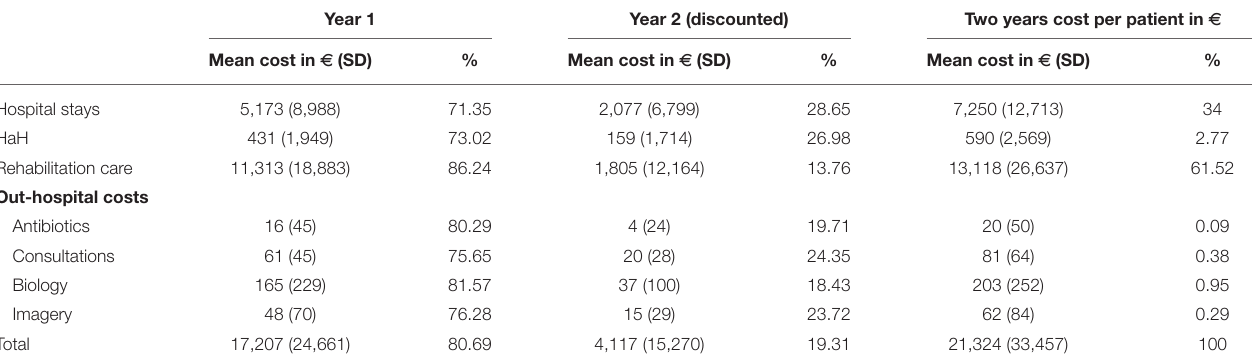
TABLE 2 | Cost of care by follow-up year and type of resource consumption per patient.